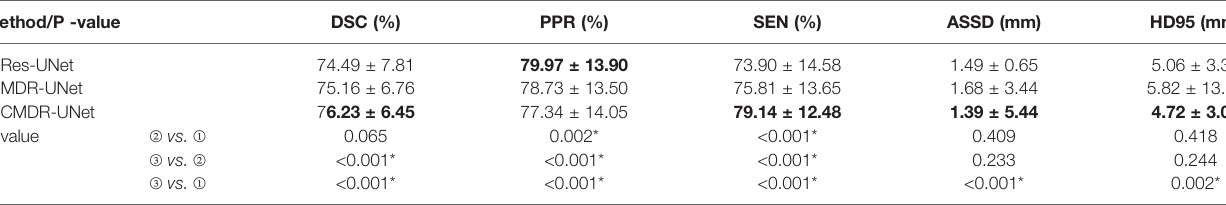
TABLE 3 | Comparison of the effects of adding the ASPP blocks and the proposed cascade architecture.